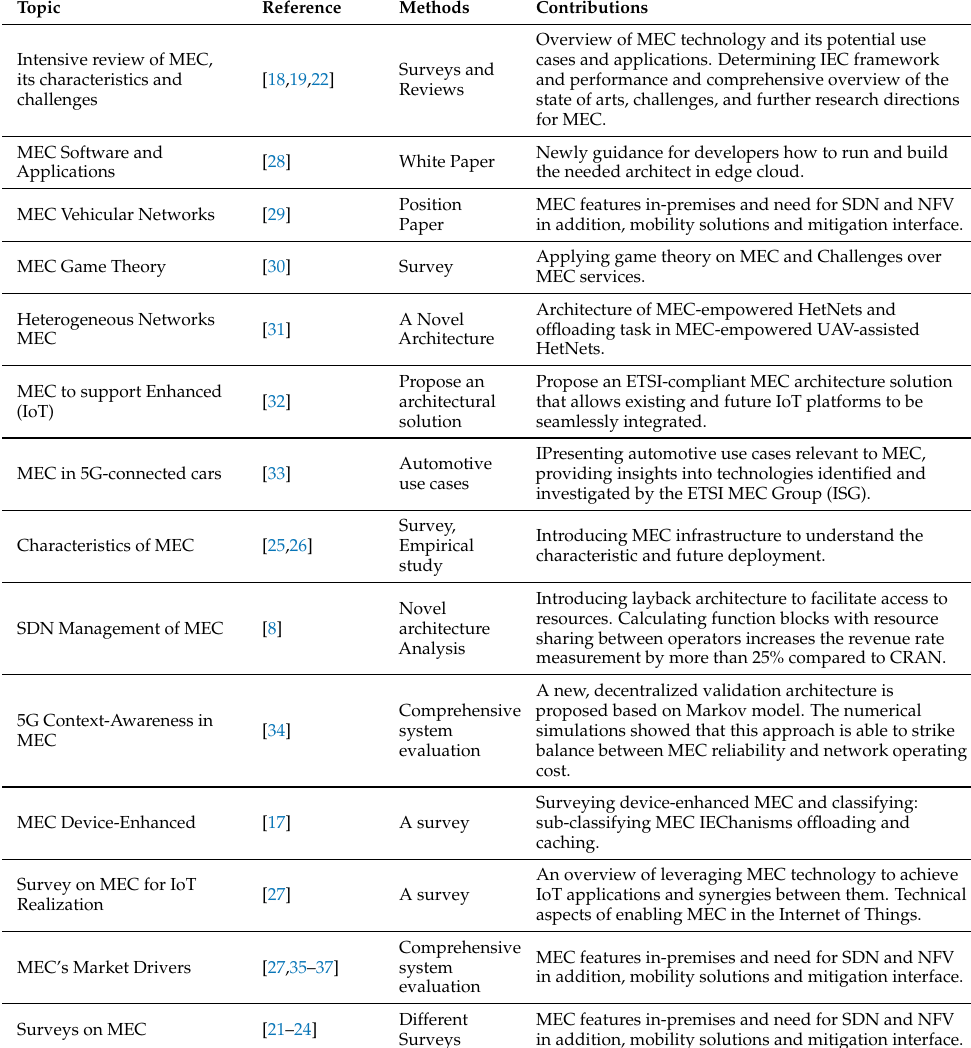
Table 1. Reviews of